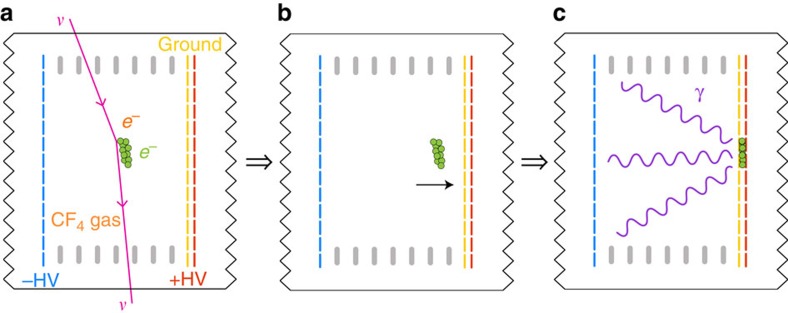
Schematic representation of the detection principle in a direction-sensitive detector.A detector vessel is filled with CF4 (or other) gas at low or high pressure. A uniform electric field is created by applying a potential difference across cathode (blue) and ground (yellow) planes that are electrically joined via step-down field cage rings (grey) at the outer extremity of the fiducial volume. (a) A target electron (orange) in the gas-filled volume recoils when struck by an incoming neutrino (magenta), depositing a substantial fraction of its kinetic energy as ionization (green) along its path. (b) The electric field then drifts this primary ionization to an amplification region, consisting of closely spaced ground and anode (red) planes with a strong electric field between them. (c) There, the ionization electrons undergo proportional multiplication, emitting electroluminescence or scintillation light (violet) and producing an image of the two-dimensional projection of the electron recoil track onto the amplification plane. If the amplification plane is read out with sufficient granularity and the diffusion in the drift volume is sufficiently small, the axial angle of the recoil track can be reconstructed, while the vector direction can be determined from the variation of the ionization density along the track. The track extent in the drift coordinate can additionally be reconstructed using fast readout of the charge time distribution of the avalanche signal.